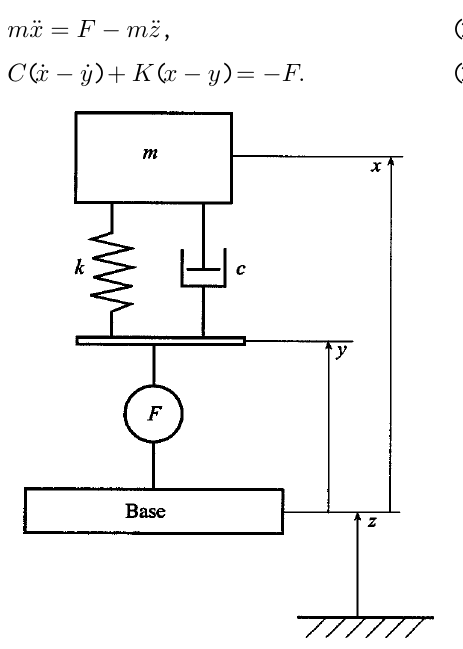
Fig. 1. A heavy body with a Voigt element attached to a moving base by an